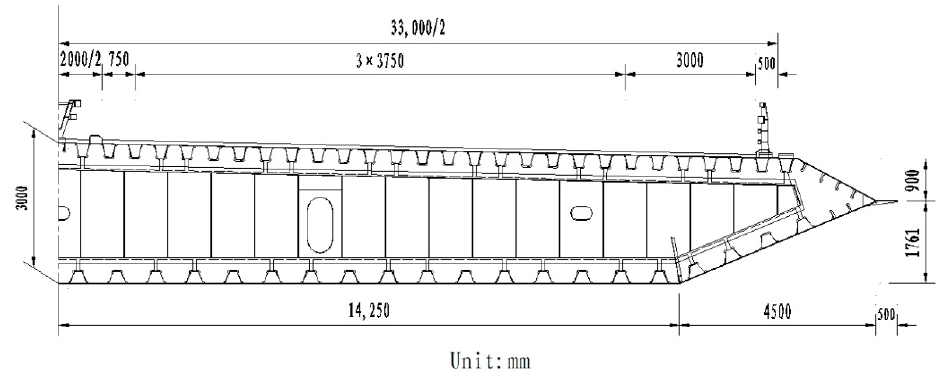
Figure 4. Half of the cross-section of an orthotropic deck steel box girder.